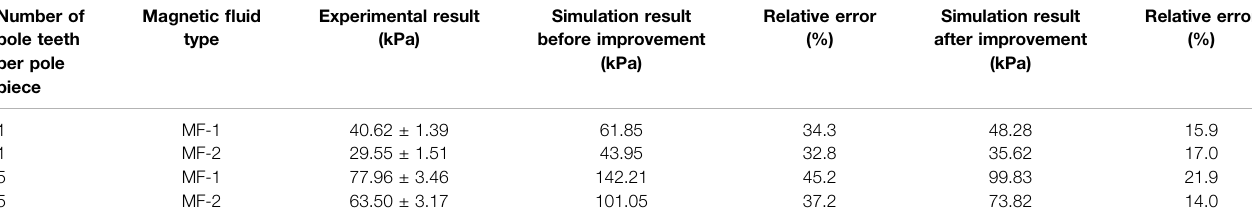
TABLE 3 | Comparison between experimental and simulation results under different MFS conditions. Number of pole teeth per pole